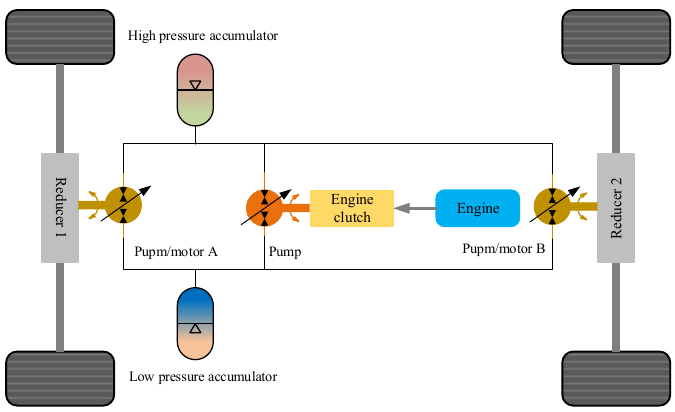
Figure 13. Configuration of the parallel hydraulic 6 × 6 medium truck [91,92].